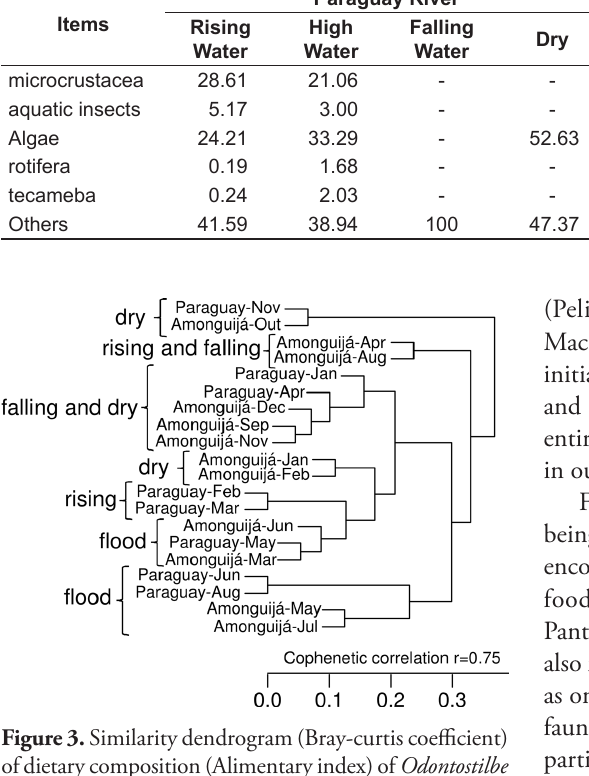
Table 1. Variation in diet composition using alimentary index among hydrological periods and rivers of Odontostilbe pequira in the Paraguay and Amonguijá rivers, southern Pantanal at Porto Murtinho, Brazil. Items